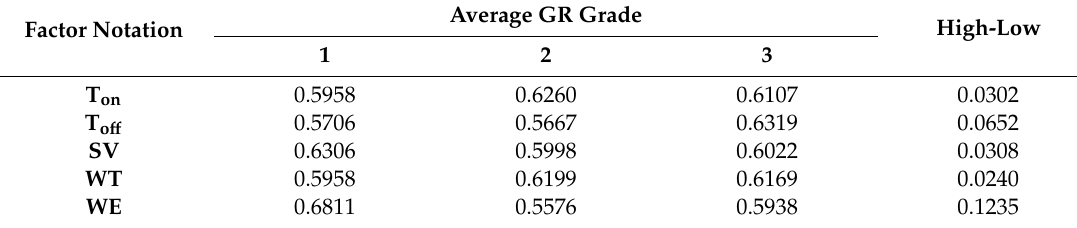
Table 5. Average GR grade for input factors.